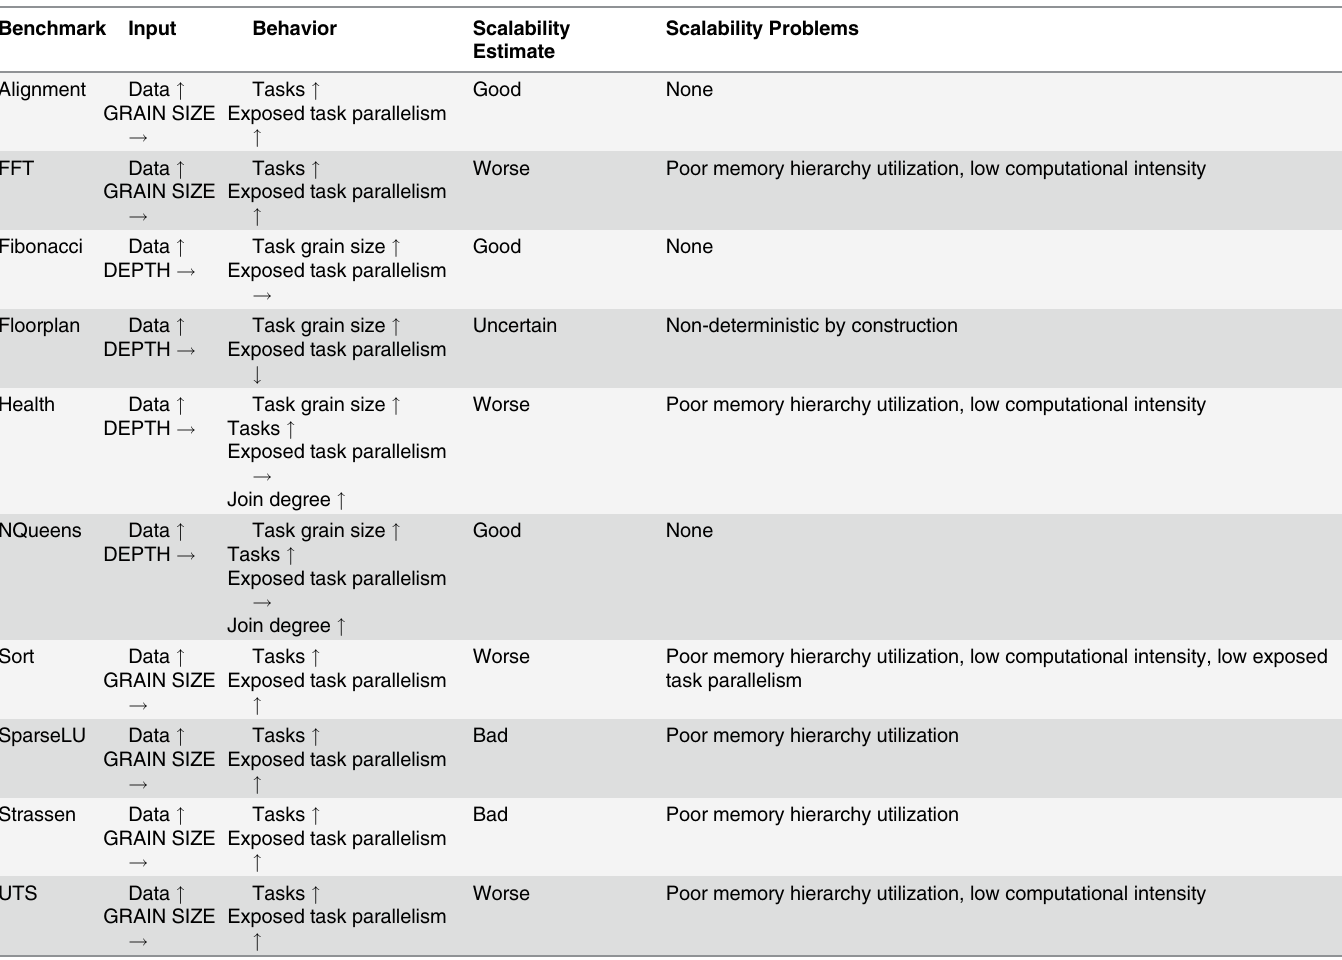
Table 6. Summary of BOTS input sensitivity study. The symbol " quantifies increasing, # decreasing and ! fixed input values. Benchmark